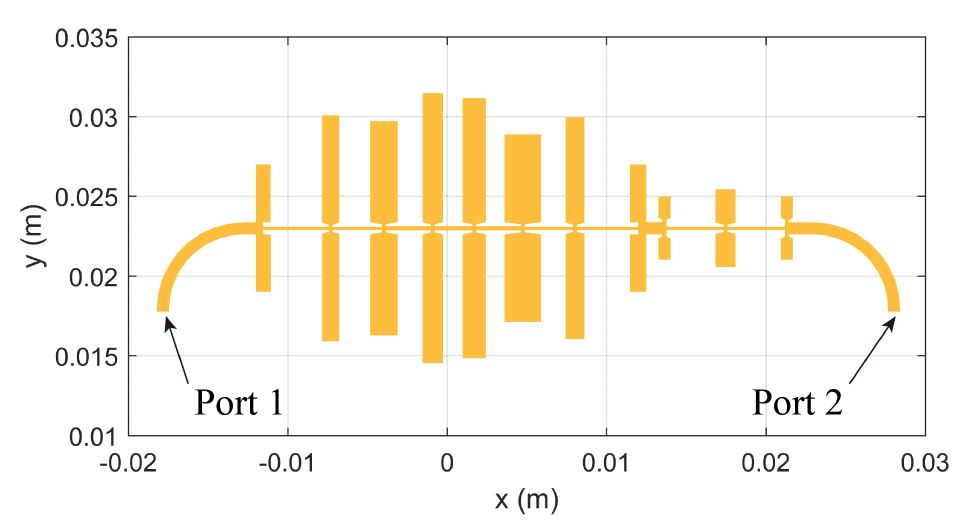
Figure 6. Metallization pattern of a microstrip two − port low − pass filter.